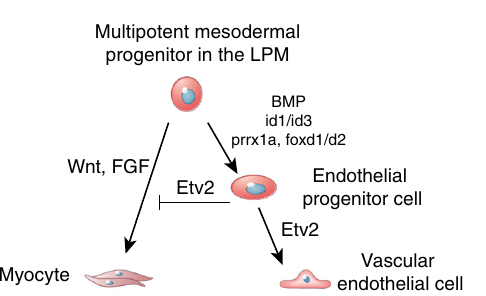
Fig. 9 A proposed model for the differentiation of vascular endothelial cells from the multipotent mesodermal progenitors in the LPM. Wnt and FGF signaling promotes myocyte differentiation of multipotent progenitors in the lateral plate mesoderm (LPM). BMP signaling through its downstream effectors id1 and id3 promotes vascular endothelial differentiation. Additional LPM markers that include prrx1a, foxd1, foxd2 and others may be involved in this process, although their role is purely speculative at this point. Etv2 promotes vascular endothelial differentiation while directly or indirectly repressing Confocal Imaging Core. Fluorescent cells within the skeletal muscle were counted manually within the entire trunk region by analyzing confocal z-stacks.